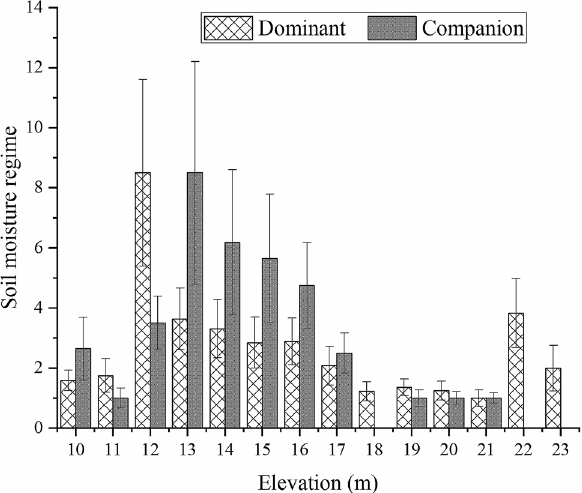
Figure 10. Changes in soil water weight with elevation of the C. cinerascens